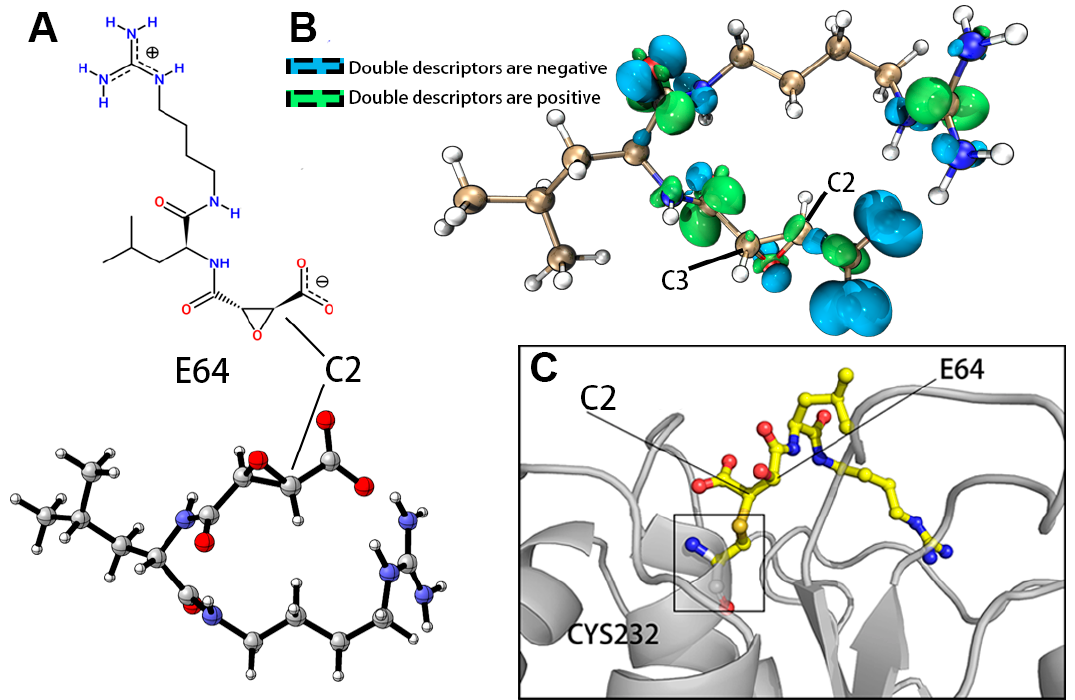
Figure 2. The molecular and optimized structures of the E64 inhibitor. ( A ) 2D and 3D structures of E64 optimized by quantum chemistry program (ORCA 5.03, Theoretical level BLYP-D3/def2 SVP def2/J CPCM (water)). ( B ) Isosurface Plots of the dual descriptors (orbital weights and Fukui functions) for the E64 molecule. The positive and negative isosurface values are directly set as 0.02 and − 0.02 respectively. ( C )The C-S covalent bond between CYS232 and E64. CYS-232 is displayed with white carbon skeleton and sulfur atoms are shown in yellow. Table 2. Activity descriptors of C2 and C3 atoms for E64 inhibitors calculated by density functional theory.